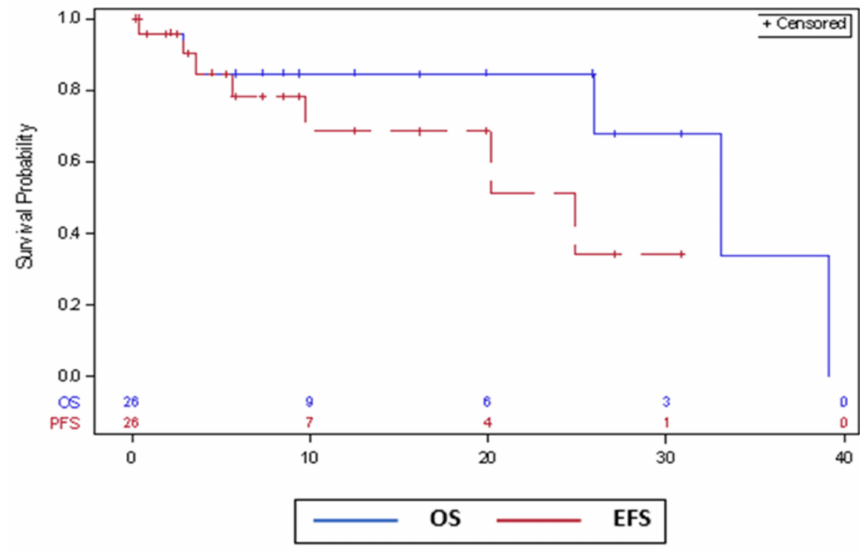
Figure 1. Event-free survival (EFS) and overall survival (OS) curves.